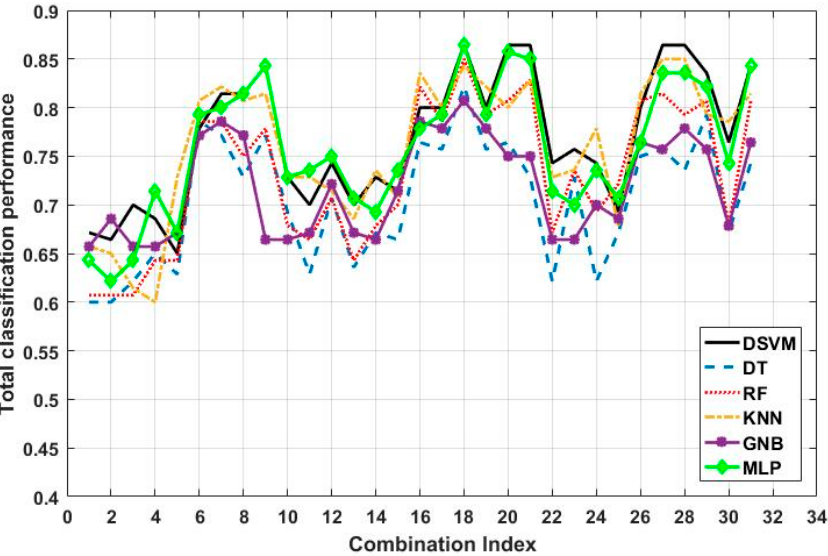
Figure 10. Total classification accuracy versus combination index for classifying cardboard from the rest for different classification approaches using SKF cross-validation.